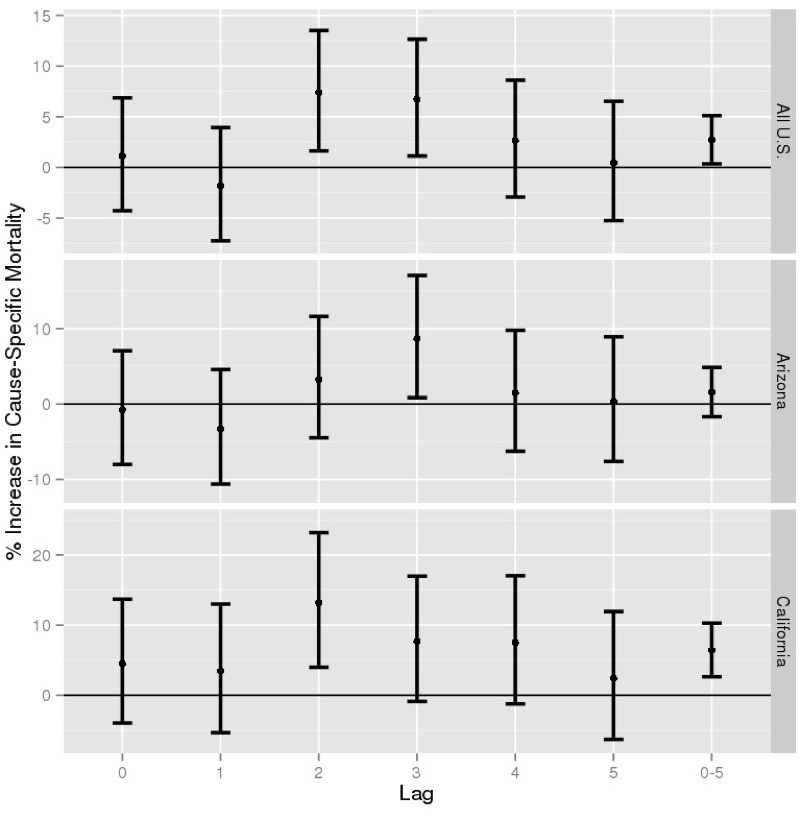
Percent increase in total non-accidental mortality associated with dust storms, compared with control days, by location and lag, for the years 1993–2005. Non-accidental mortalities fall under ICD-9 codes 000–799 and ICD-10 codes A000–R999. Associations are estimated using a distributed lag model for dust storm events with non-linear control for temperature (natural spline with 3 degrees of freedom). The y-axes limits differ between locations.